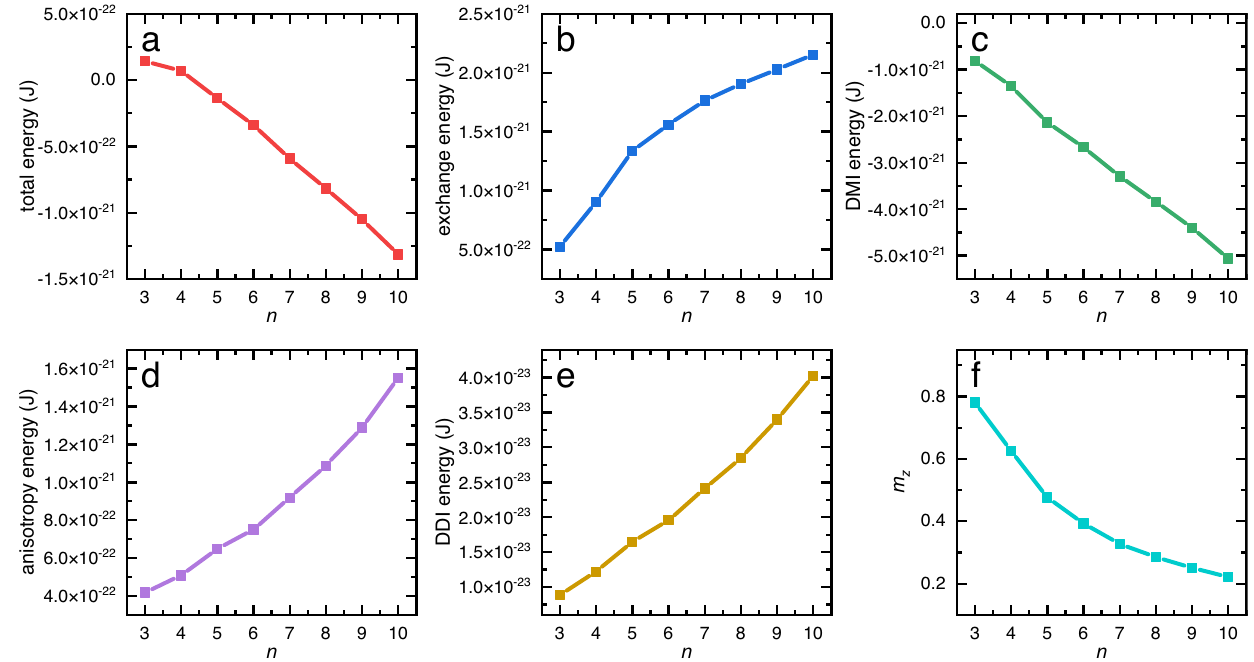
Fig. 7 Size dependence of the energy of the meron in units of Joule. a The total energy. b The exchange energy. c The DMI energy. d The easy-plane magnetic anisotropy energy. e The magnetic dipole – dipole energy. f The normalized out-of-plane magnetization. The radius of the meron is n = 7. The simulation parameters are given in the caption of Fig. 2. More details are given in the “ Methods ” section.